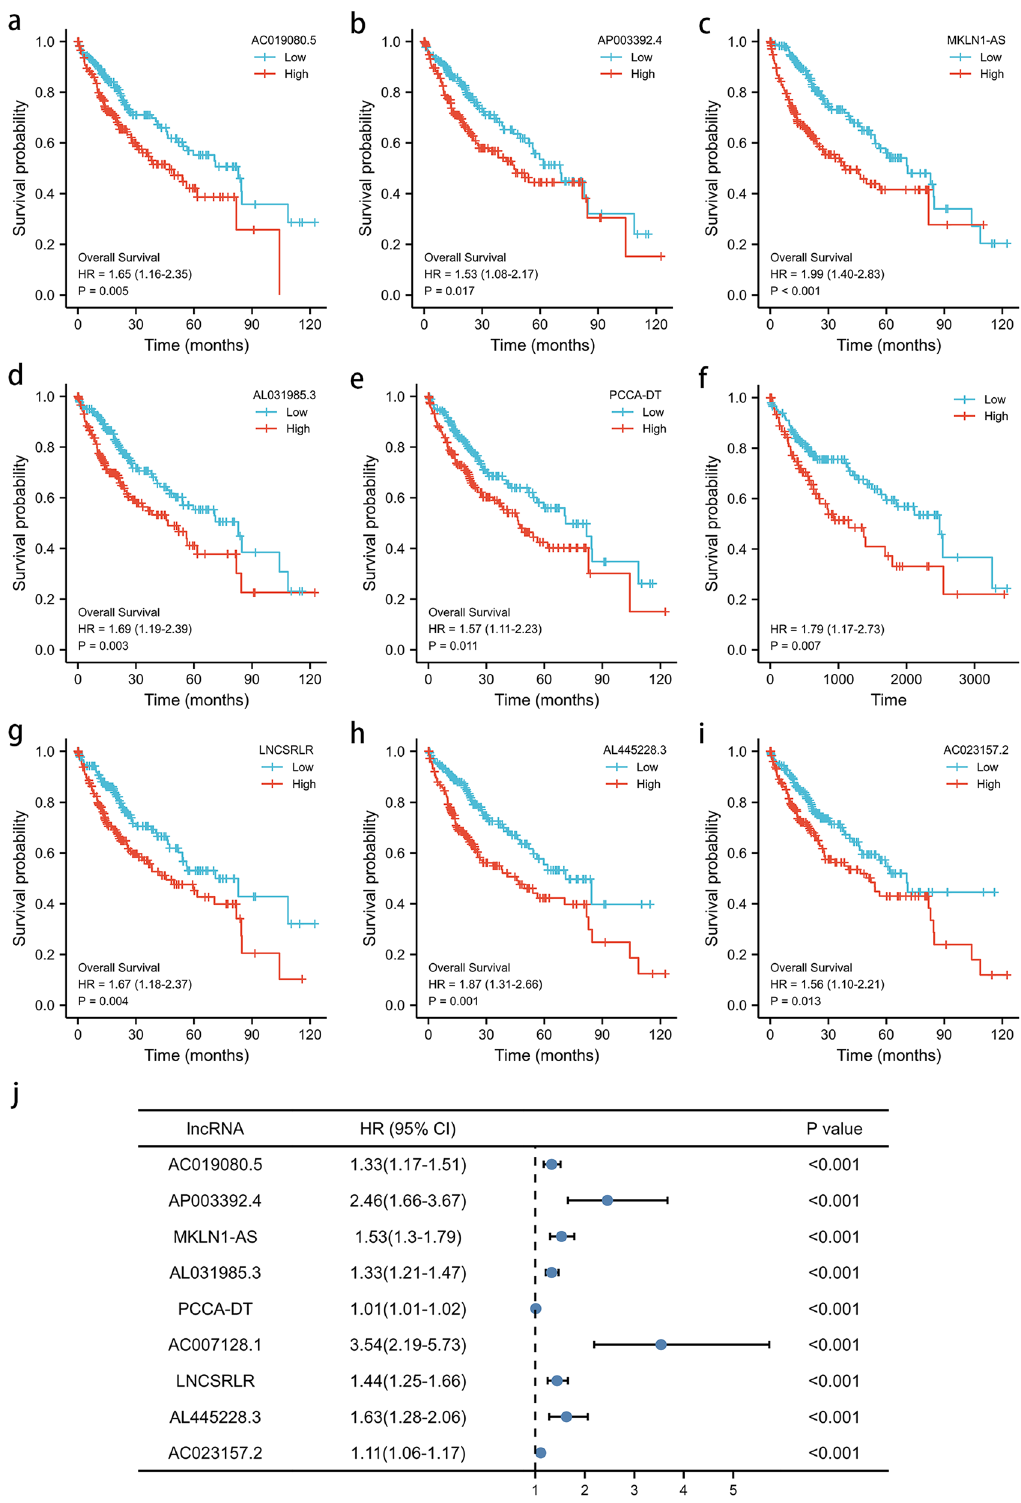
Figure 2. The prognostic value of pyroptosis-associated lncRNAs in HCC patients. ( a – i ) Kaplan-Meire curve of AC019080.5 ( a ), AP003392.4 ( b ), MKLN1-AS ( c ), AL031985.3 ( d ), PCCA-DT ( e ), AC007128.1 ( f ),